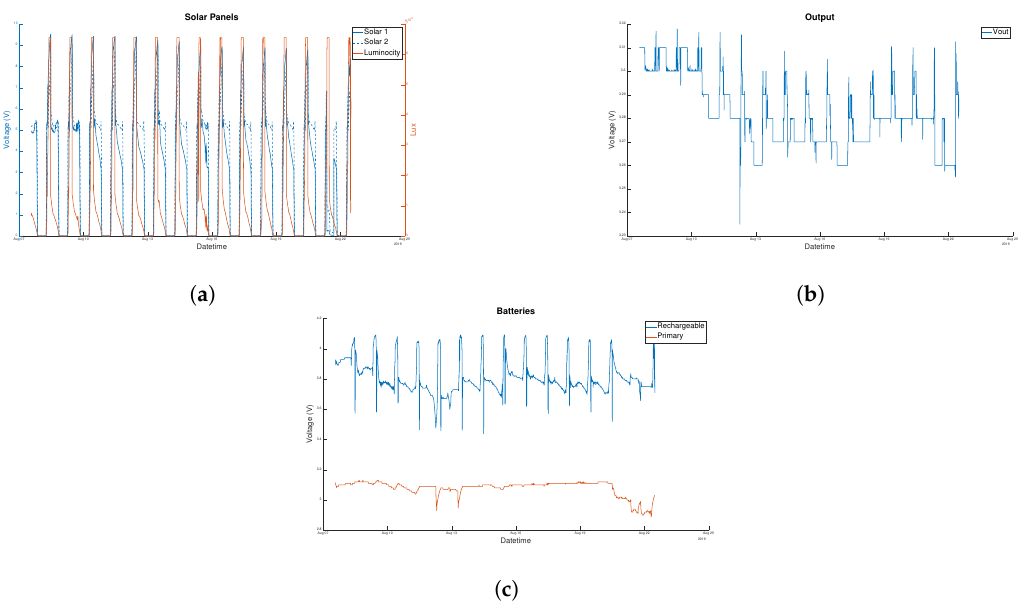
Figure 15. Results from an evaluation of the energy management board encapsulated in resin for the duration of 15 days. ( a ) Solar panels voltage. Solar 1: 2 panels, Solar 2: 6 panels. ( b ) Output voltage. ( c ) Rechargeable and non-rechargeable battery